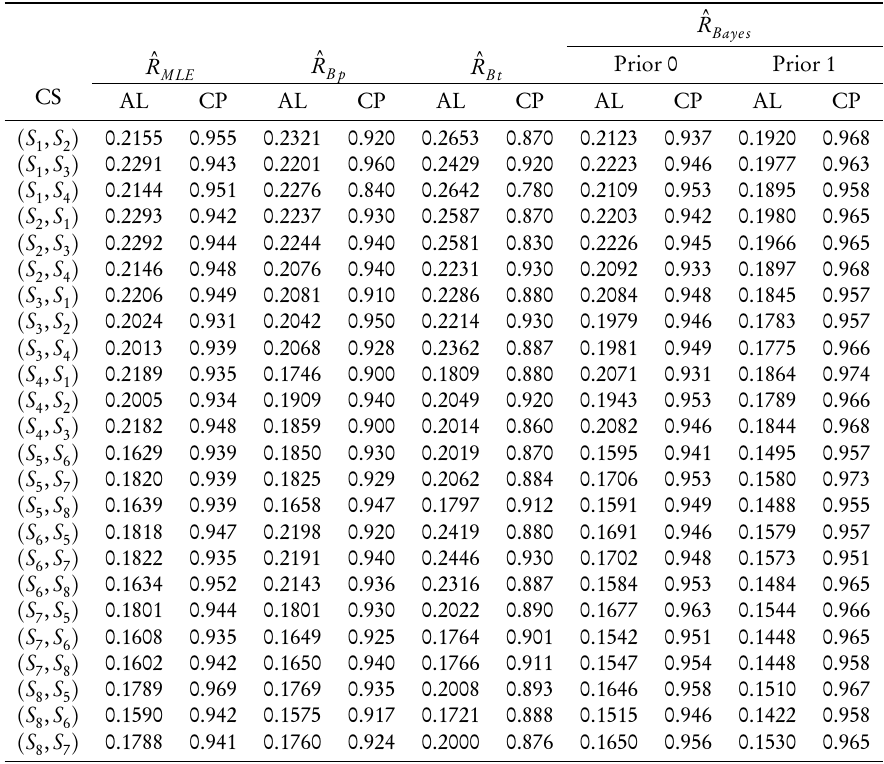
The AL and CP of 95% asymptotic, bootstrap confidence / HPD credible intervals of R when α = 0.75, β = 3, λ = 1 and R =